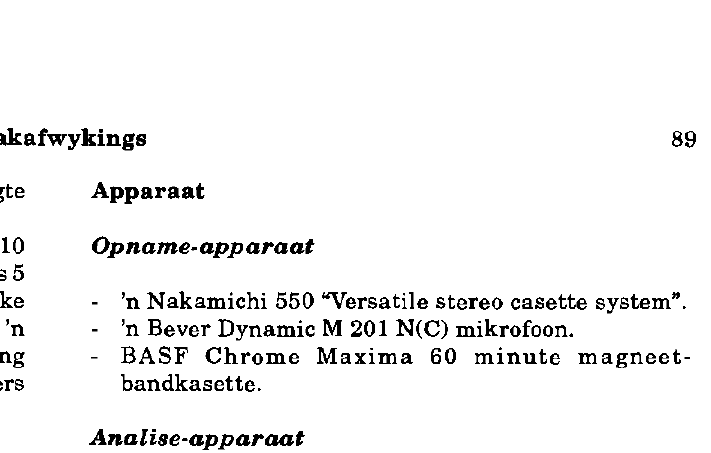
Tabel 1. Samestelling van die teikenmateriaal en die gemete spraakparameters binne elke